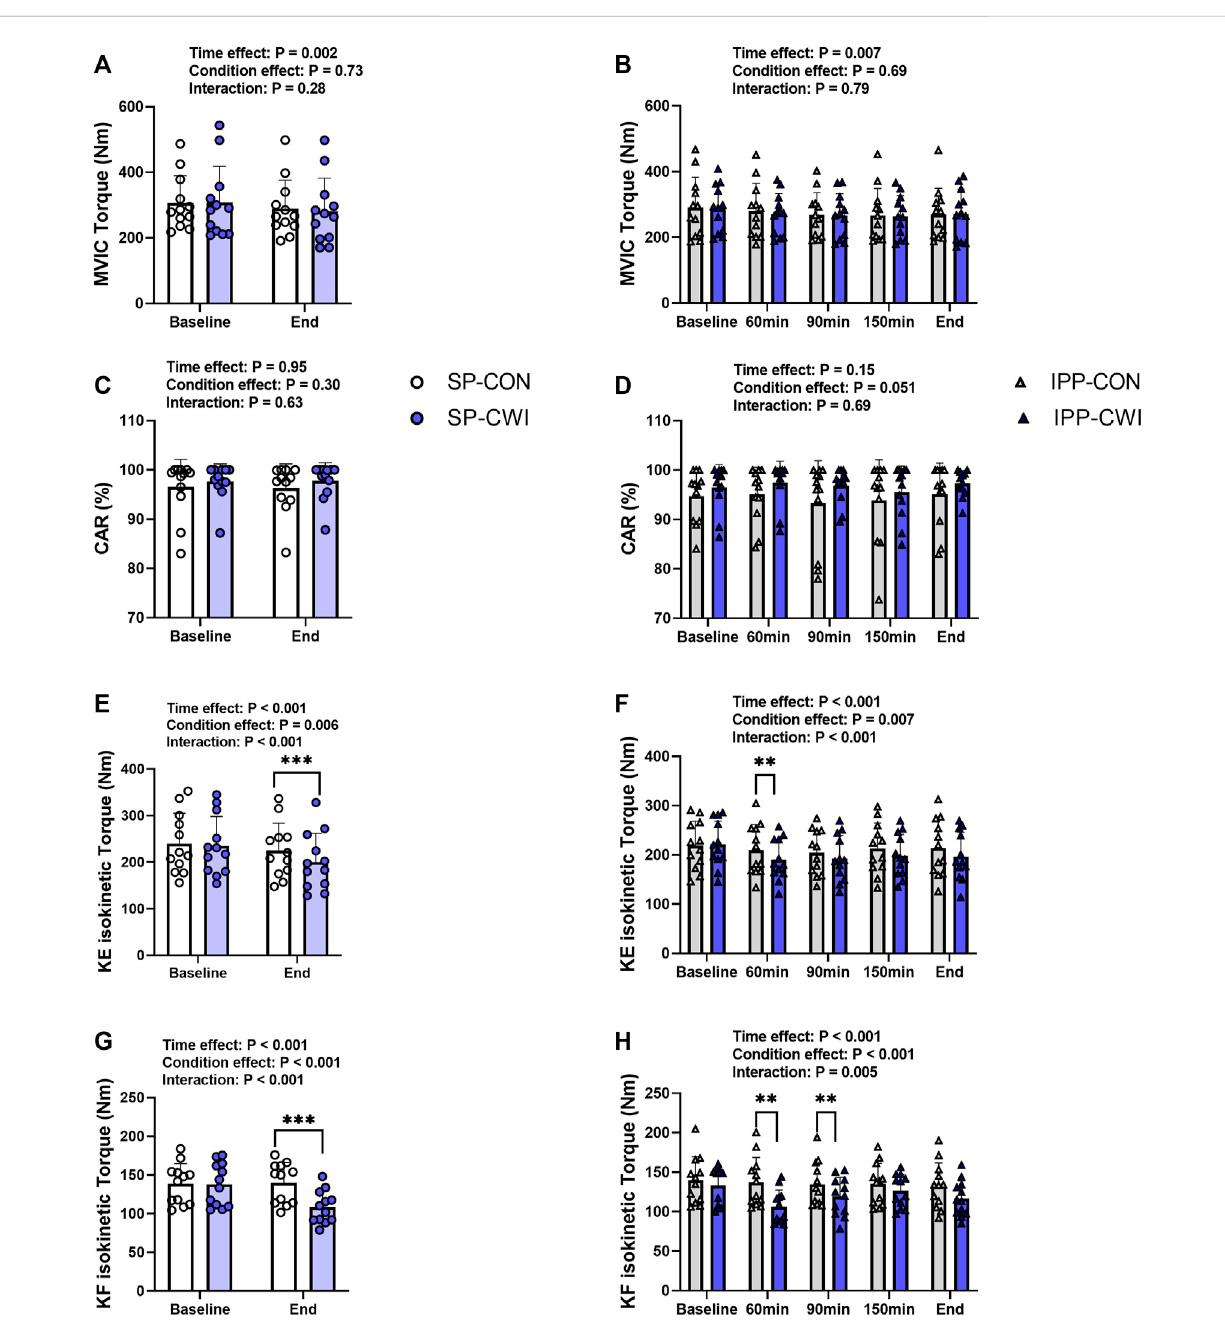
FIGURE 5 Maximal voluntary contraction torques and central activation ratio (CAR) in the unfatigued state. Maximal voluntary isometric contraction (MVIC) torques (A,B) ,CAR (C,D) ,kneeextension(KE)maximalisokinetictorques (E,F) ,andknee fl exion(KF)maximalisokinetictorques (G,H) duringthesingleand intermittent/prolonged phases, respectively. Data are shown as mean ± SD and all panels include individual values. SP, single phase; IPP, intermittent/ prolonged phase. **, p < 0.01; ***, p < 0.001: Signi fi cant differences CON vs. CWI. N =